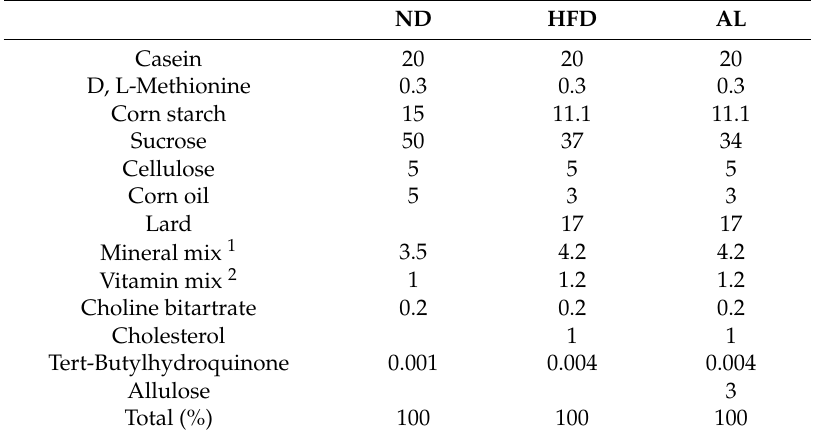
Table 1. Composition of experimental diets with or without allulose